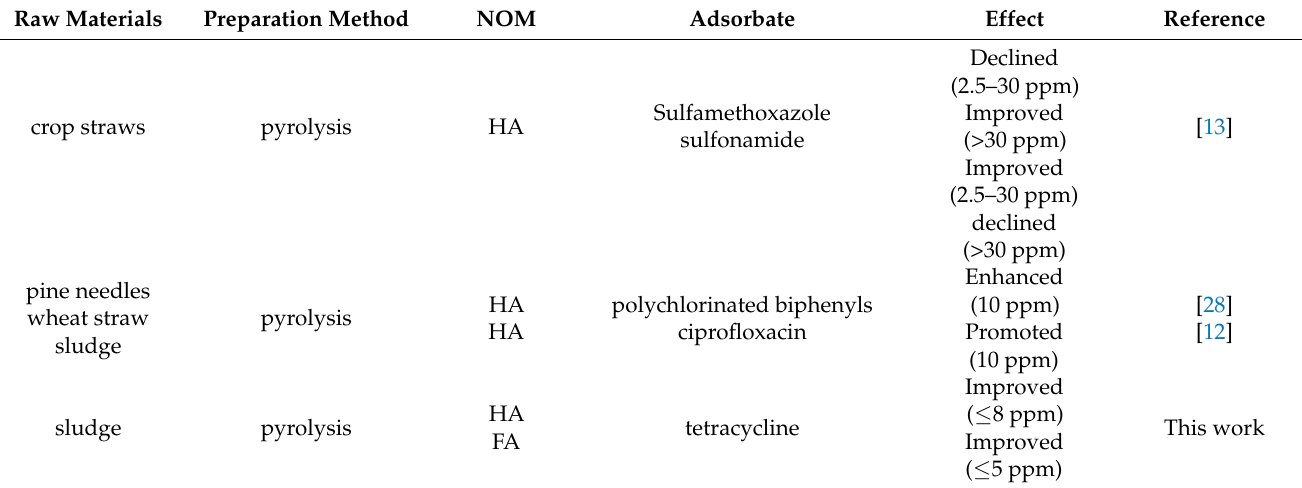
Table 1. The effect of NOM on the adsorption behavior of organic contaminants by